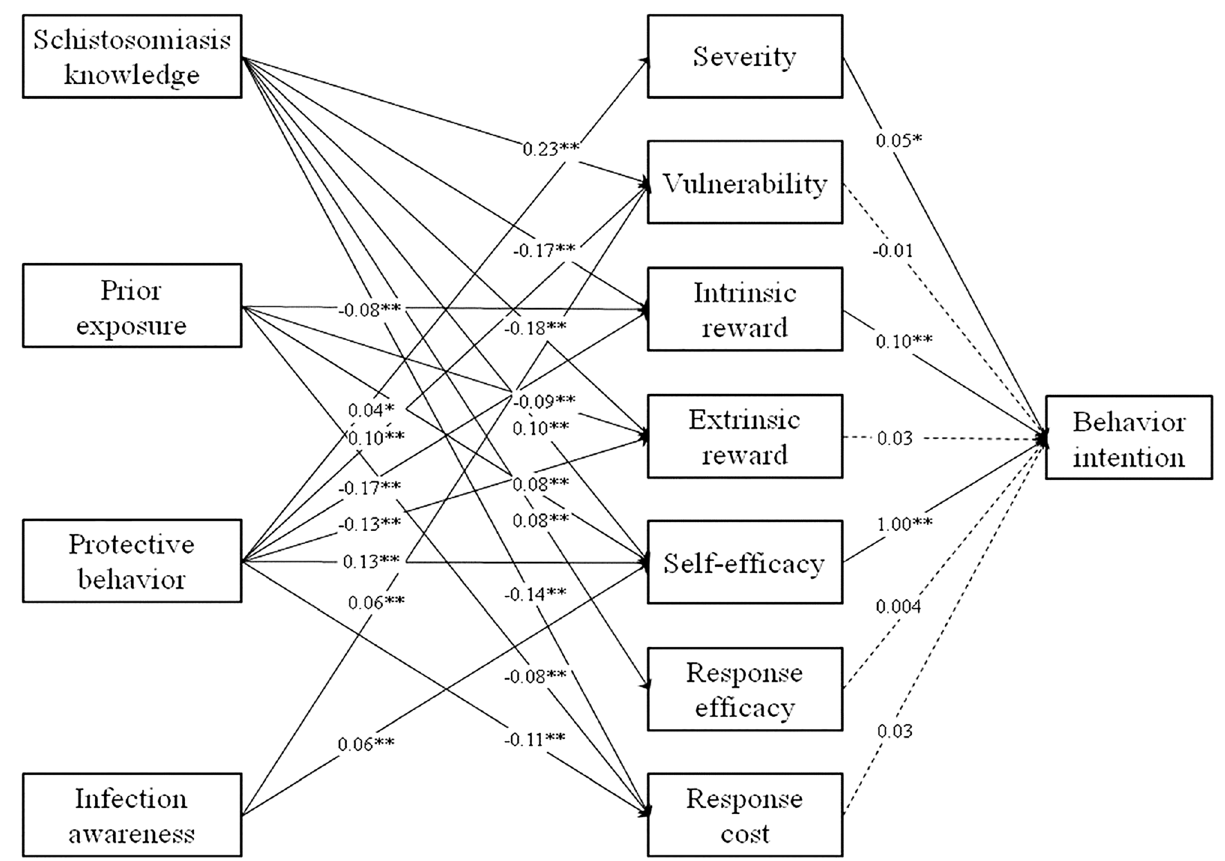
Figure 2. Structural equation modeling of schistosomiasis knowledge, prior exposure, awareness, protective behavior, schistosomiasis PMT constructs and behavior intention. The data-model fit indices: GFI=0.98, CFI=0.93, RMSEA=0.06, Chi-square/df=8.6. **: p , 0.01 and *: p , 0.05.